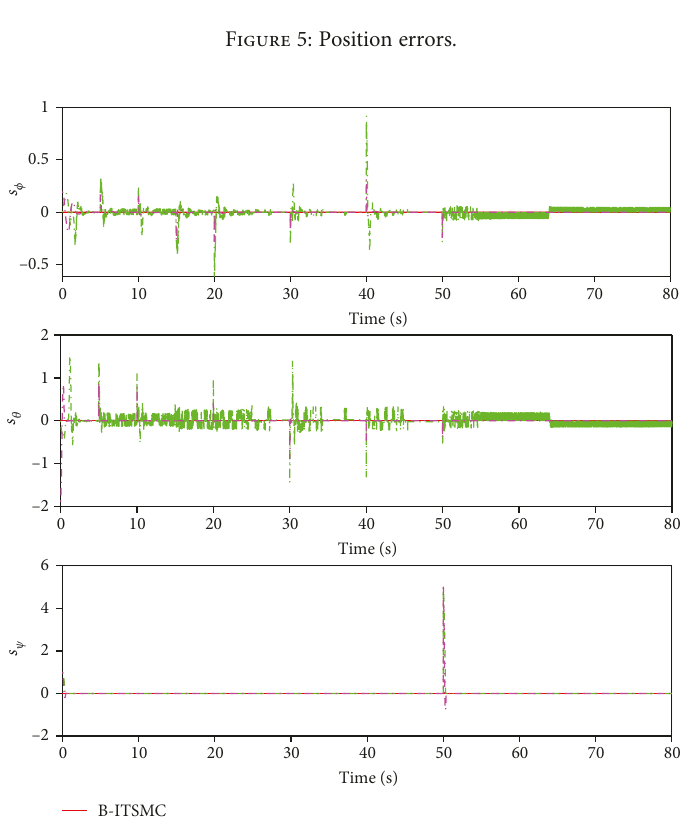
Figure 6: Tracking errors ( s